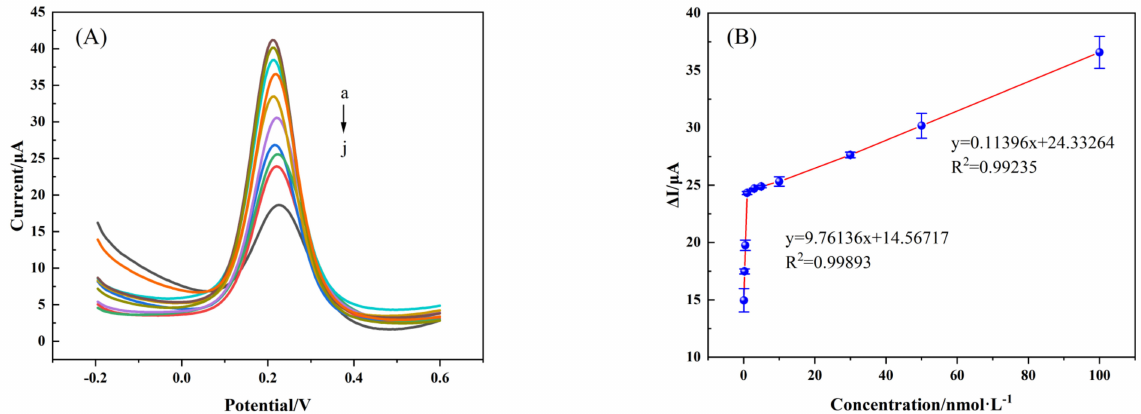
Figure 9. ( A ) DPV plots in 5 mmol · L − 1 [Fe (CN) 6 ] 3 − /4 − (1.0 mol · L − 1 KCl) obtained from MIP/TBC/GCE after incubation with different concentrations of NOR (0.1, 0.3, 0.5, 1, 3, 5, 10, 30, 50, 100 nM) (a → j); ( B ) The relationship between current difference ( ∆ I) and the concentrations of NOR. ∆ I = I 0 − I 1 , I 0 and I 1 were the peak currents obtained from electrodes before and after incubation with various concentrations of NOR solution.